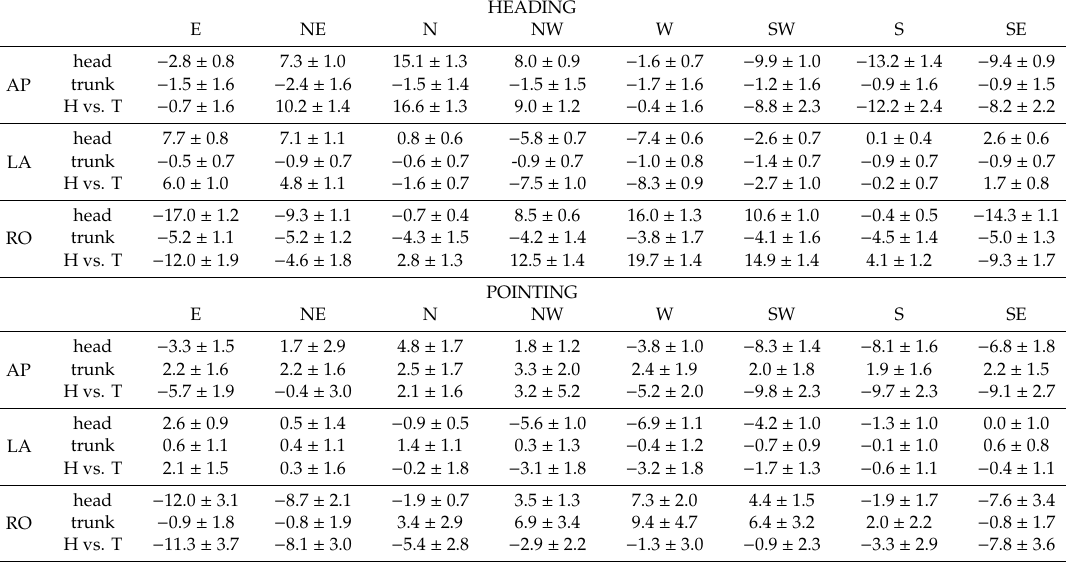
Figure 3. Variation of the head orientation by reference to the trunk as a function of target direction. The graphs represent the Euler angles (anterior/posterior tilt, lateral tilt and axial rotation) describing the orientation of the head relative to the trunk at the time of heading (blue circles) and pointing (pink circles). Each point represents the mean ± SEM of 10 participants. Table 1. Mean values for 10 participants of Euler angles (expressed in degrees) representing the orientation of the head and trunk in space and the head by reference to the trunk (H vs. T) for the different target directions. AP: Anteroposterior tilt, LA lateral tilt, RO: axial rotation. Target directions: E: East, NE: Northeast, N: North, NW: Northwest, W: West, SW: Southwest, S: South, SE: Southeast. Data are mean ± SEM.